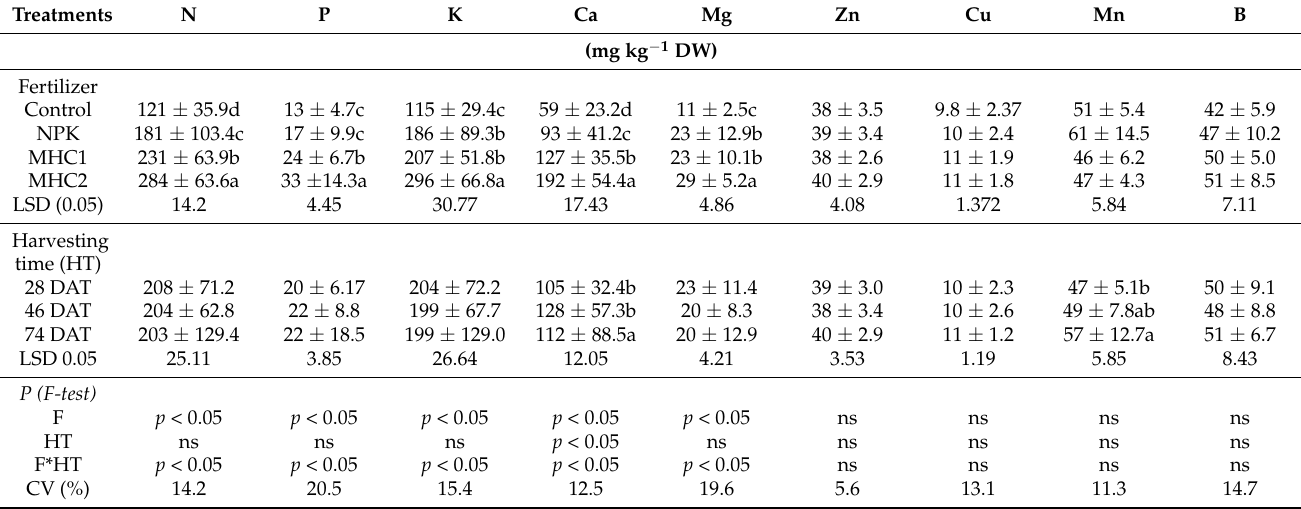
Table 5. Effect of macadamia husk compost and inorganic fertilizer on leaf nutrient concentration in